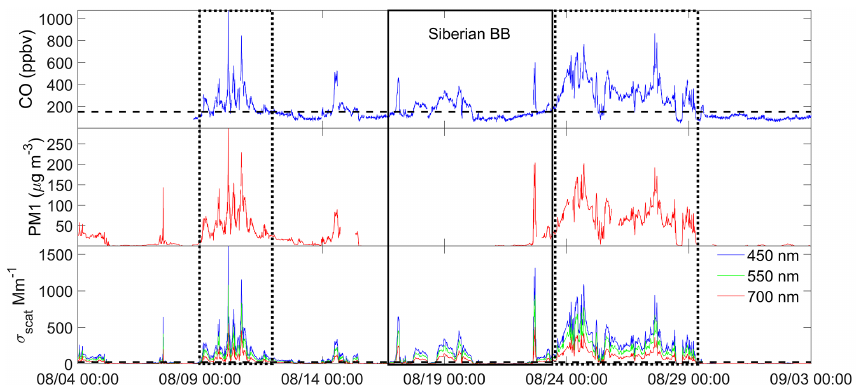
Figure 1. Time series of CO, PM 1 , and aerosol scattering ( σ scat ) at MBO during August. Threshold values (dashed black lines) used for BB event criteria are displayed for CO (150ppbv) and scattering (20Mm − 1 ) . The dotted boxes represent multi-day periods of regional BB and encompasses events 2–8 and 16–19, respectively. The solid box represents the period influenced by Siberian BB and encompasses events 10–15.